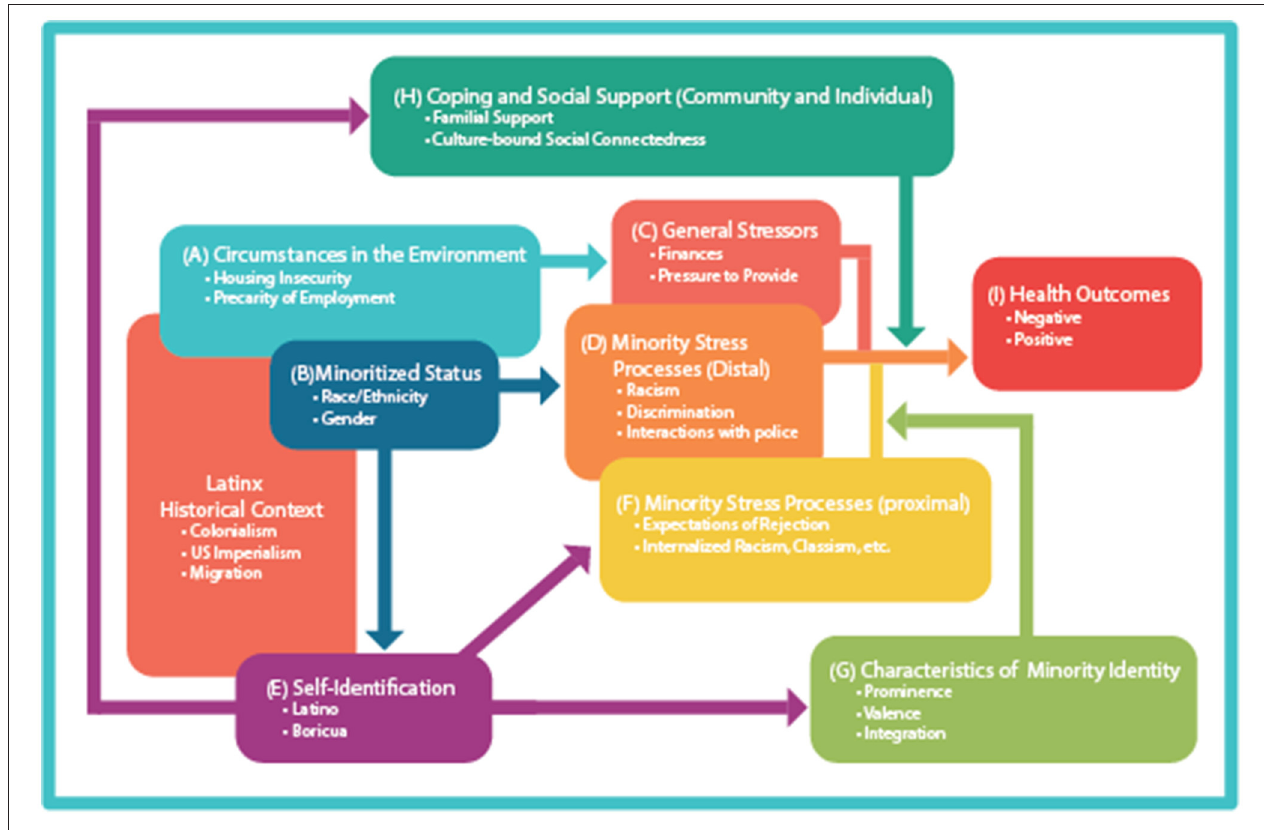
FIGURE 1 | Expanded minority stress model adapted for Latino